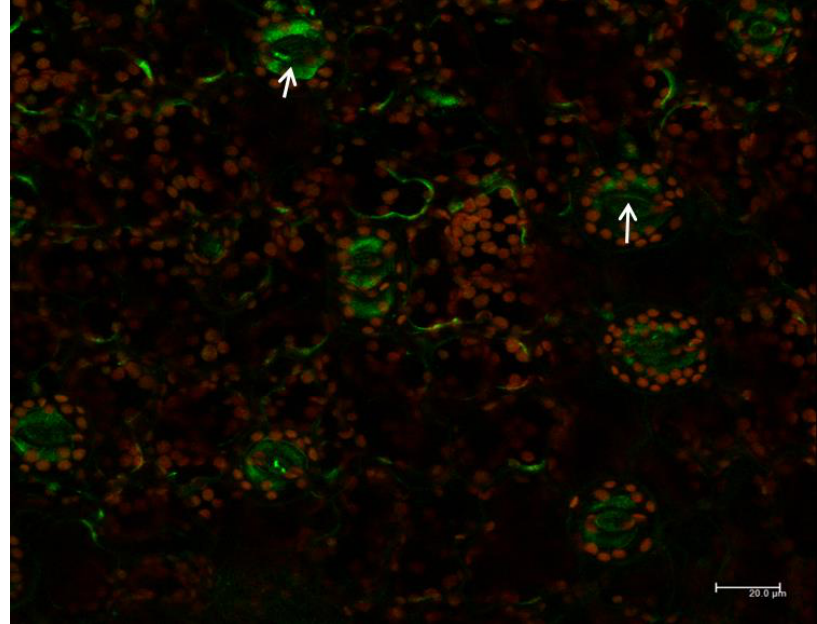
Figure 9. Localization of phosphatidylinositol 3-kinase (PI3K-GFP) in the cytoplasm and inner membrane of guard cells in transgenic (OX) Nicotiana tabacum by confocal laser scanning microscopy. Arrows denote regions showing expression in cytoplasm (Top left) and in the inner membrane of guard cell (Bottom, right). Scale represent 20.0 µm.